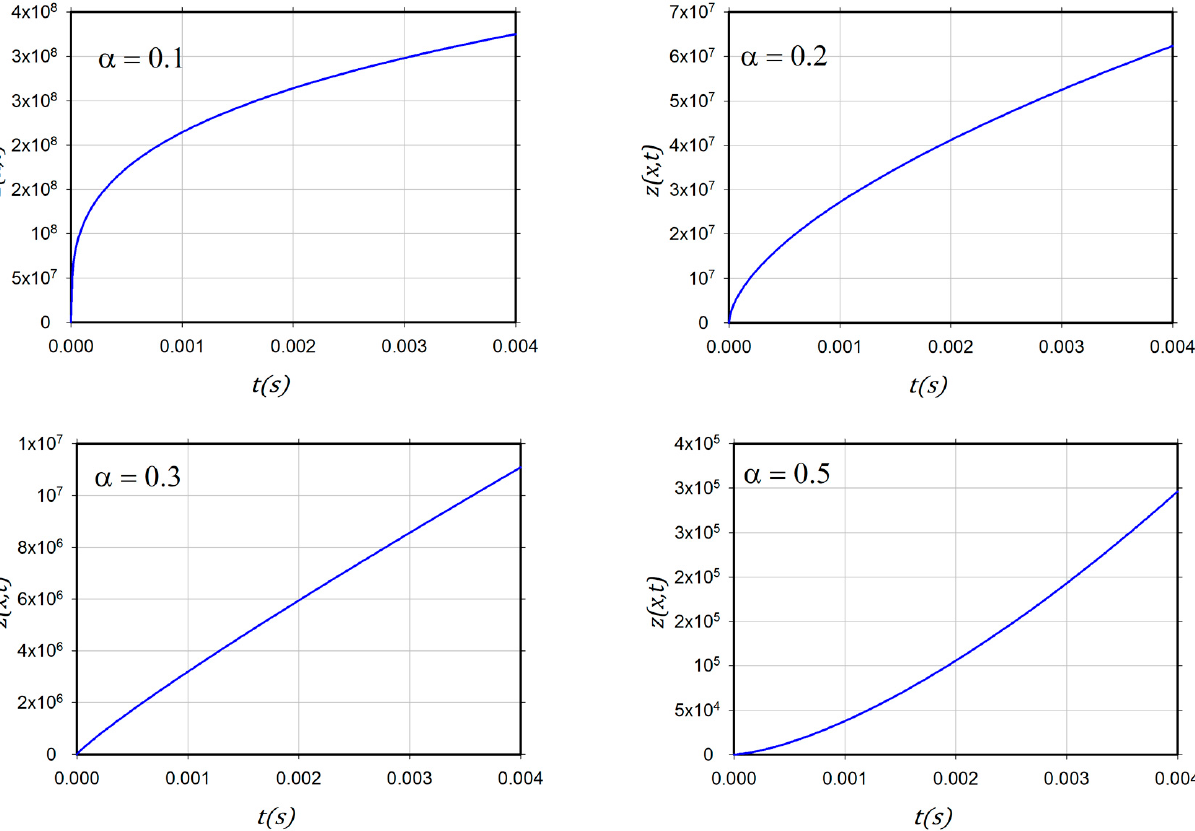
Figure 1. 2D graphs of neutron flux z ( x , t ) for α = 0.1, 0.2, 0.3, 0.5. and α , z 0 ( x ) = 1.